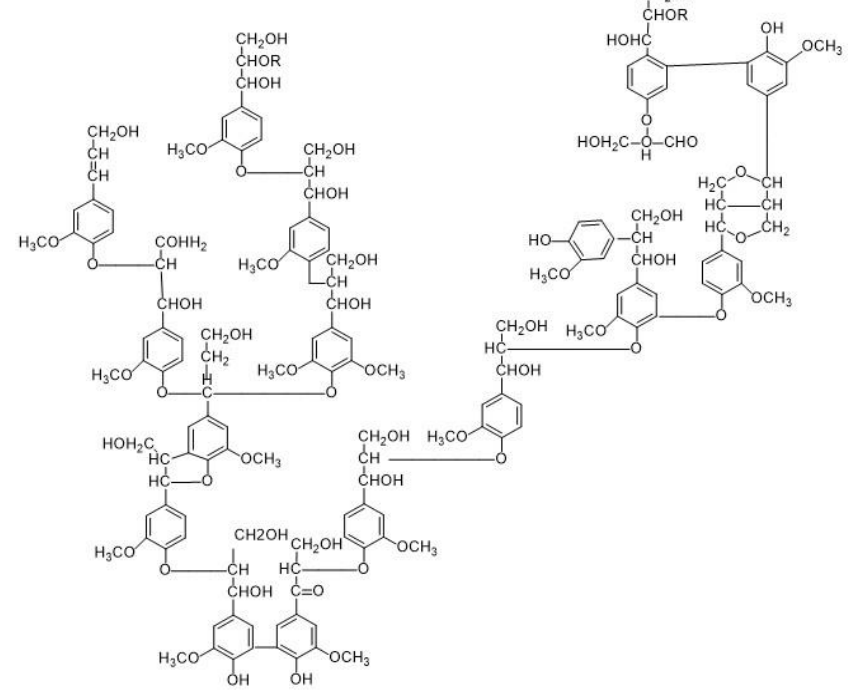
Figure 2. Structure of Lignin. Table 1. Cellulose, hemicellulose, and lignin contents in different types of agri – food biomass [23,24].